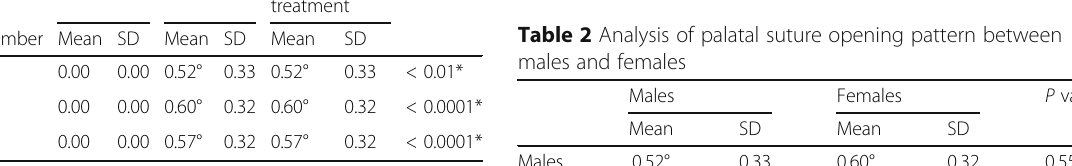
Table 1 Analysis of palatal suture opening pattern. T0, pre- expansion; T1, post-expansion T1